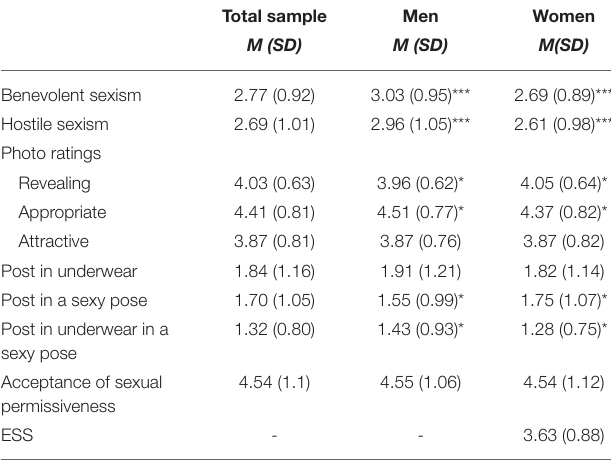
TABLE 1 | Descriptive statistics for all variables in male and female users.